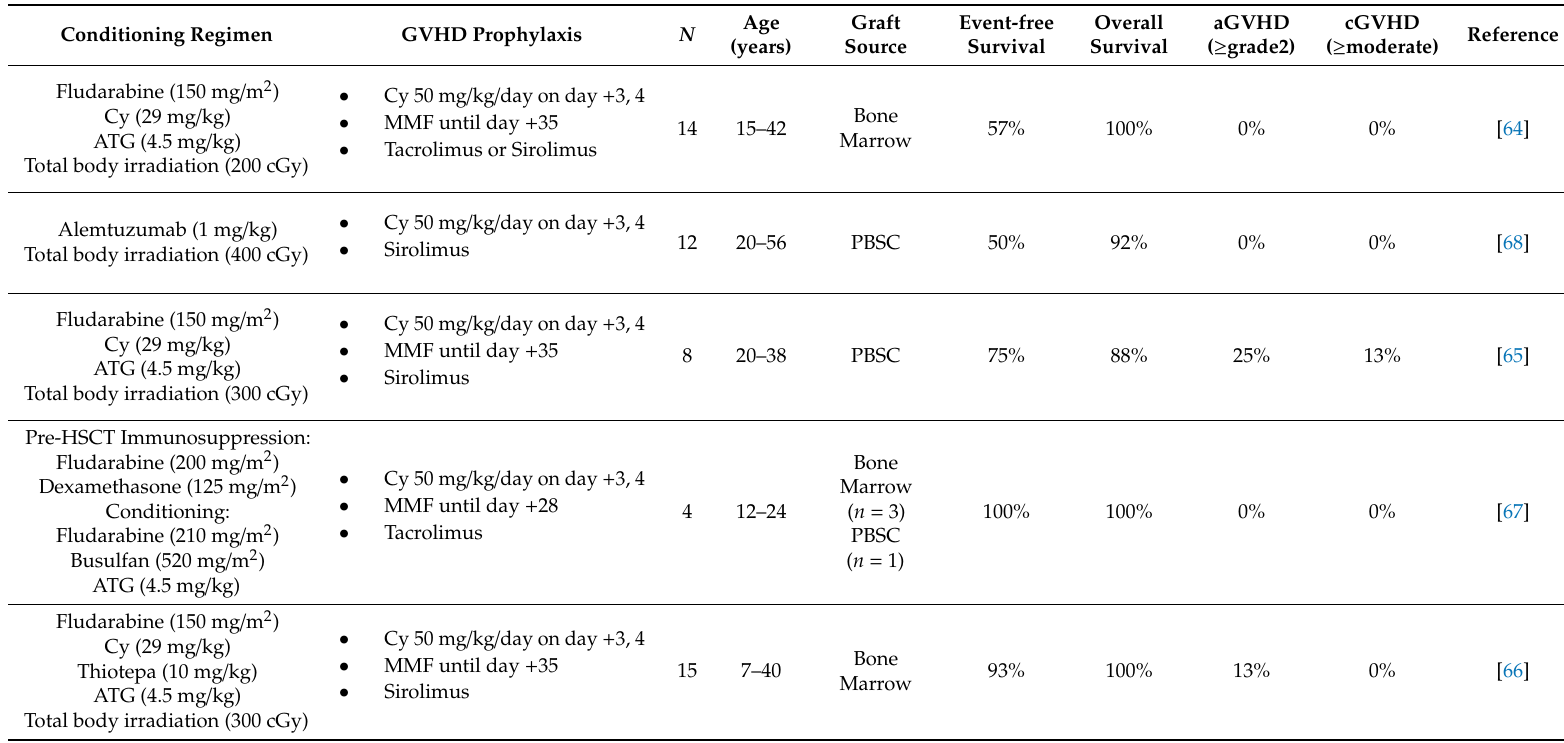
Table 4. Haploidentical hematopoietic stem cell transplantation (HSCT) in adults with